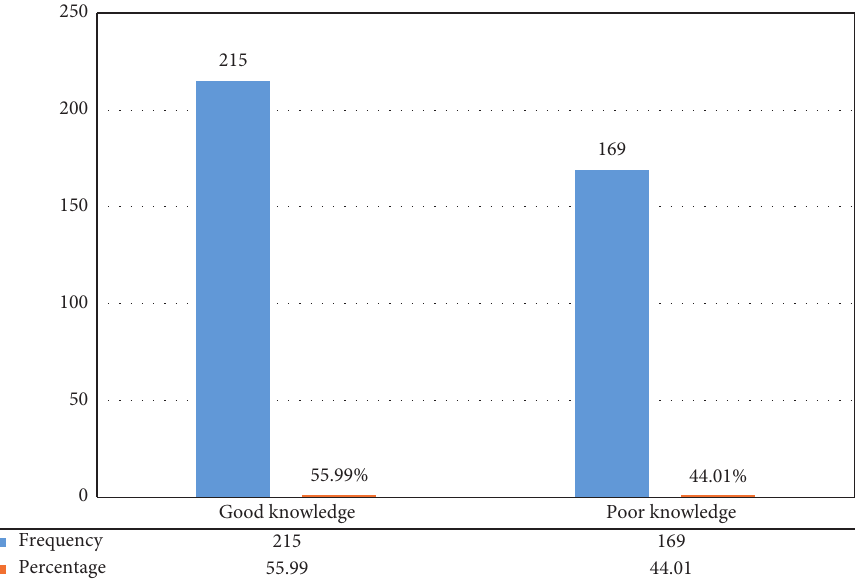
Figure 1: Knowledge level of the hypertensive patient, 2019. Table 3: Self-care practice level of hypertensive patients,